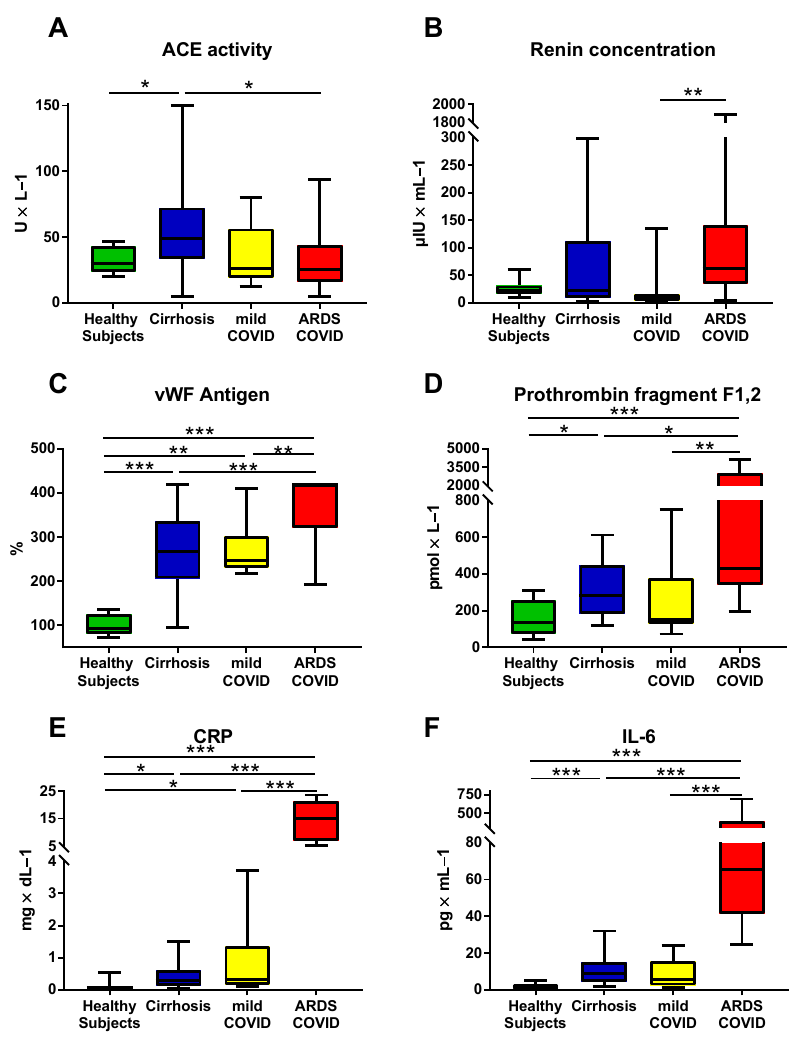
Figure 2. Comparison of plasma levels of ( A ) angiotensin-converting enzyme (ACE), ( B ) renin, ( C ) von Willebrand factor (VWF) antigen, ( D ) prothrombin fragment F1,2, ( E ) C-reactive protein (CRP), and ( F ) interleukin-6 (IL-6) between healthy subjects, cirrhotic patients, patients with mild COVID-19, and patients with ARDS COVID-19. ( A , C ) The borders of the whiskers are the minimum and maximum. ( B , D – F ) The borders of the whiskers are the 10th and the 90th percentile. * p < 0.050; ** p < 0.010; *** p <